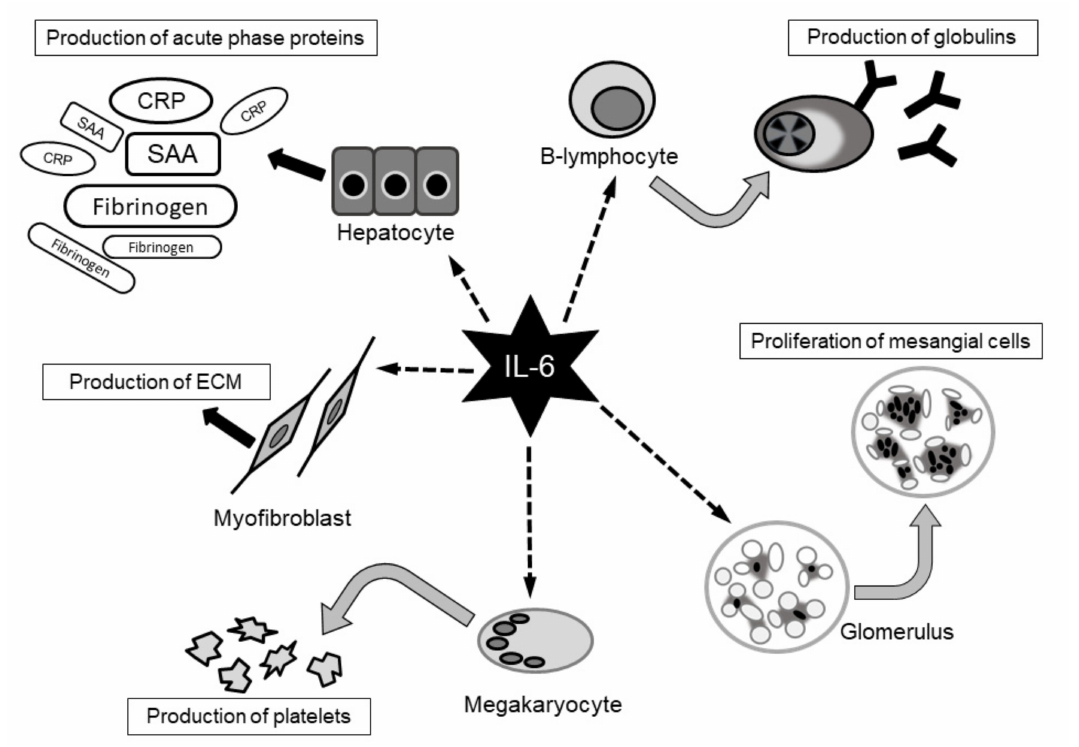
Figure 1. Pleiotropic functions of interleukin-6. It has been reported interluukin-6(IL-6) has various effect [49]. IL-6: interleukin-6, CRP: C-reactive protein, SAA: serum amyloid A, ECM: extracellular matrix.